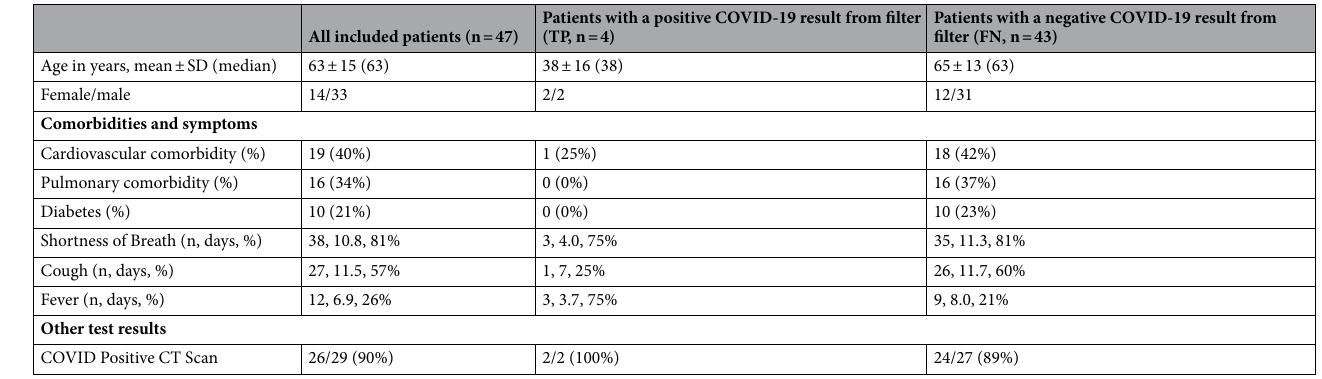
Table 2. Characteristics of COVID-19 patients. TP true positive, FN false negative.